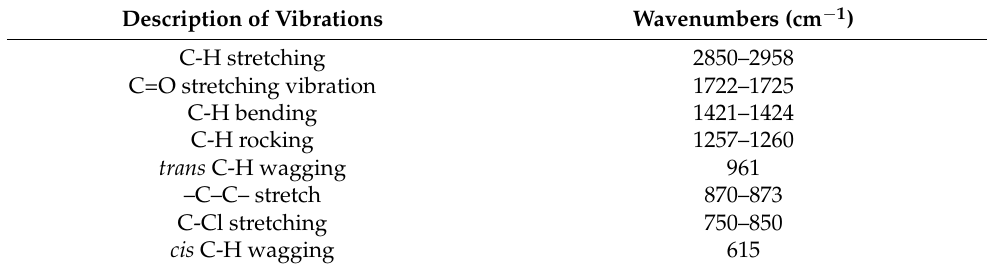
Table 3. Vibrational modes and wavenumbers observed in PVC compound [36–40].